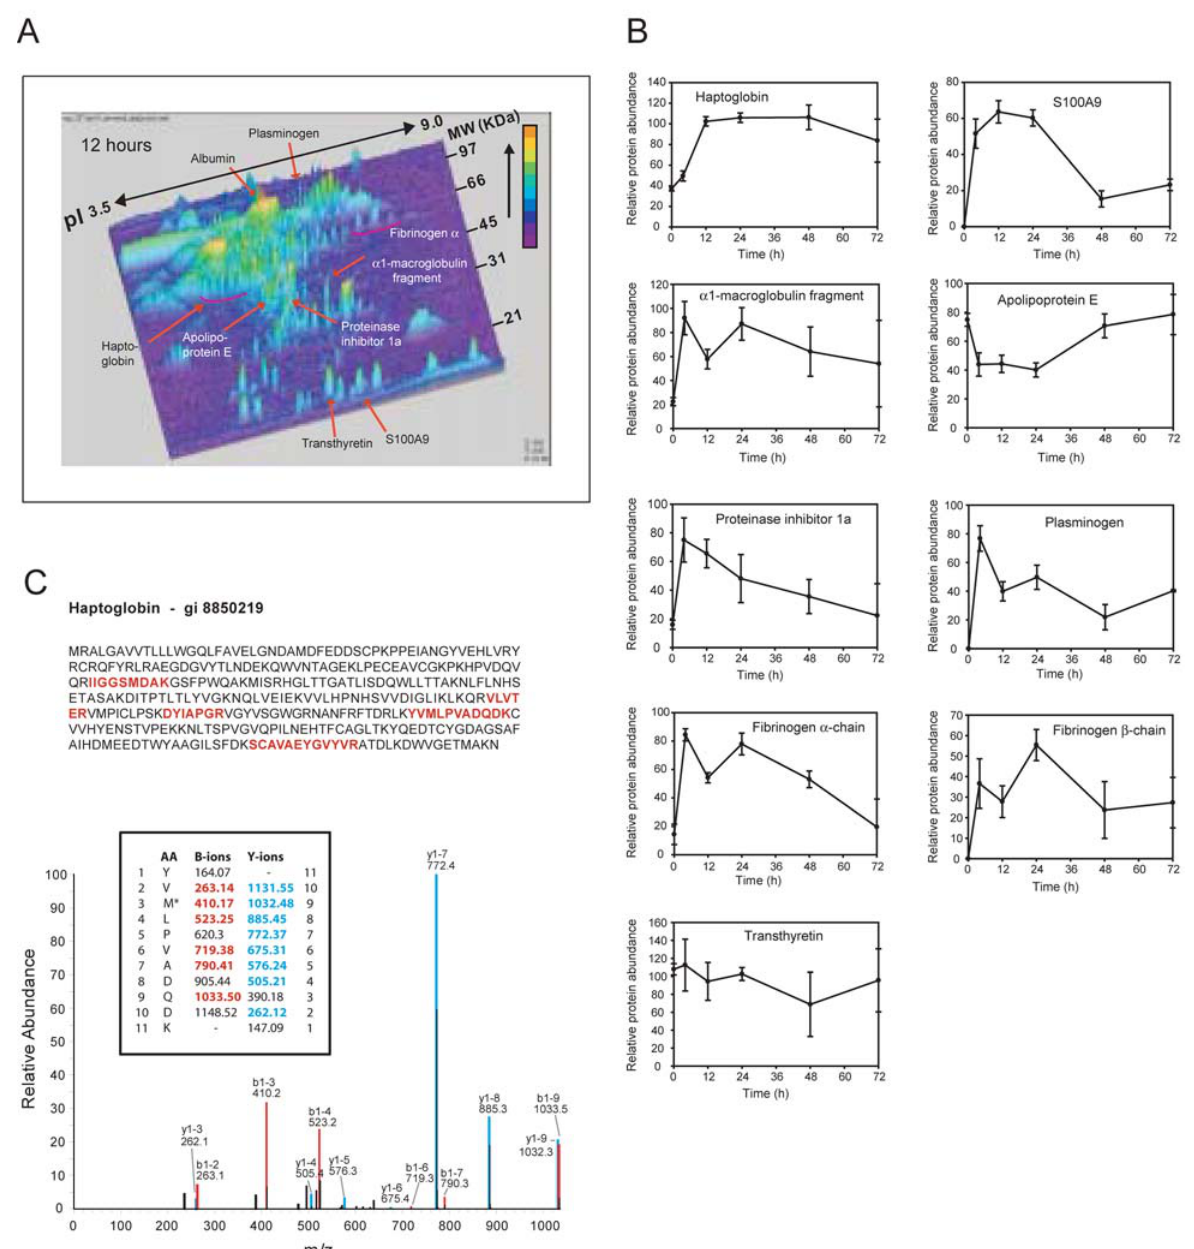
FIGURE 8. Proteomic temporal analysis of exudate proteins[37]. (A) Mice were injected with zymosan A to induce peritonitis. Exudate fluid was collected at the indicated time points and proteins were separated by 2D gel electrophoresis. Changes in individual protein levels were measured by image analysis. Selected proteins that display temporal regulation are indicated (arrows) and were identified by LC-MS/MS and peptide mapping. (B) The temporal profiles of several exudate proteins (haptoglobin, S100A9, a C-terminal fragment of α 1 - macroglobulin, apolipoprotein E, proteinase inhibitor 1 α , plasminogen, the fibrinogen α - and β –chains, and transthyretin) are shown (values are means ± SEM, n = 3–6 gels). (C) Tryptic peptide mapping of haptoglobin by MS. Peptides that are matched are shown in red. The matching of the tandem mass spectrum of peptide YVMLPVADQDK is